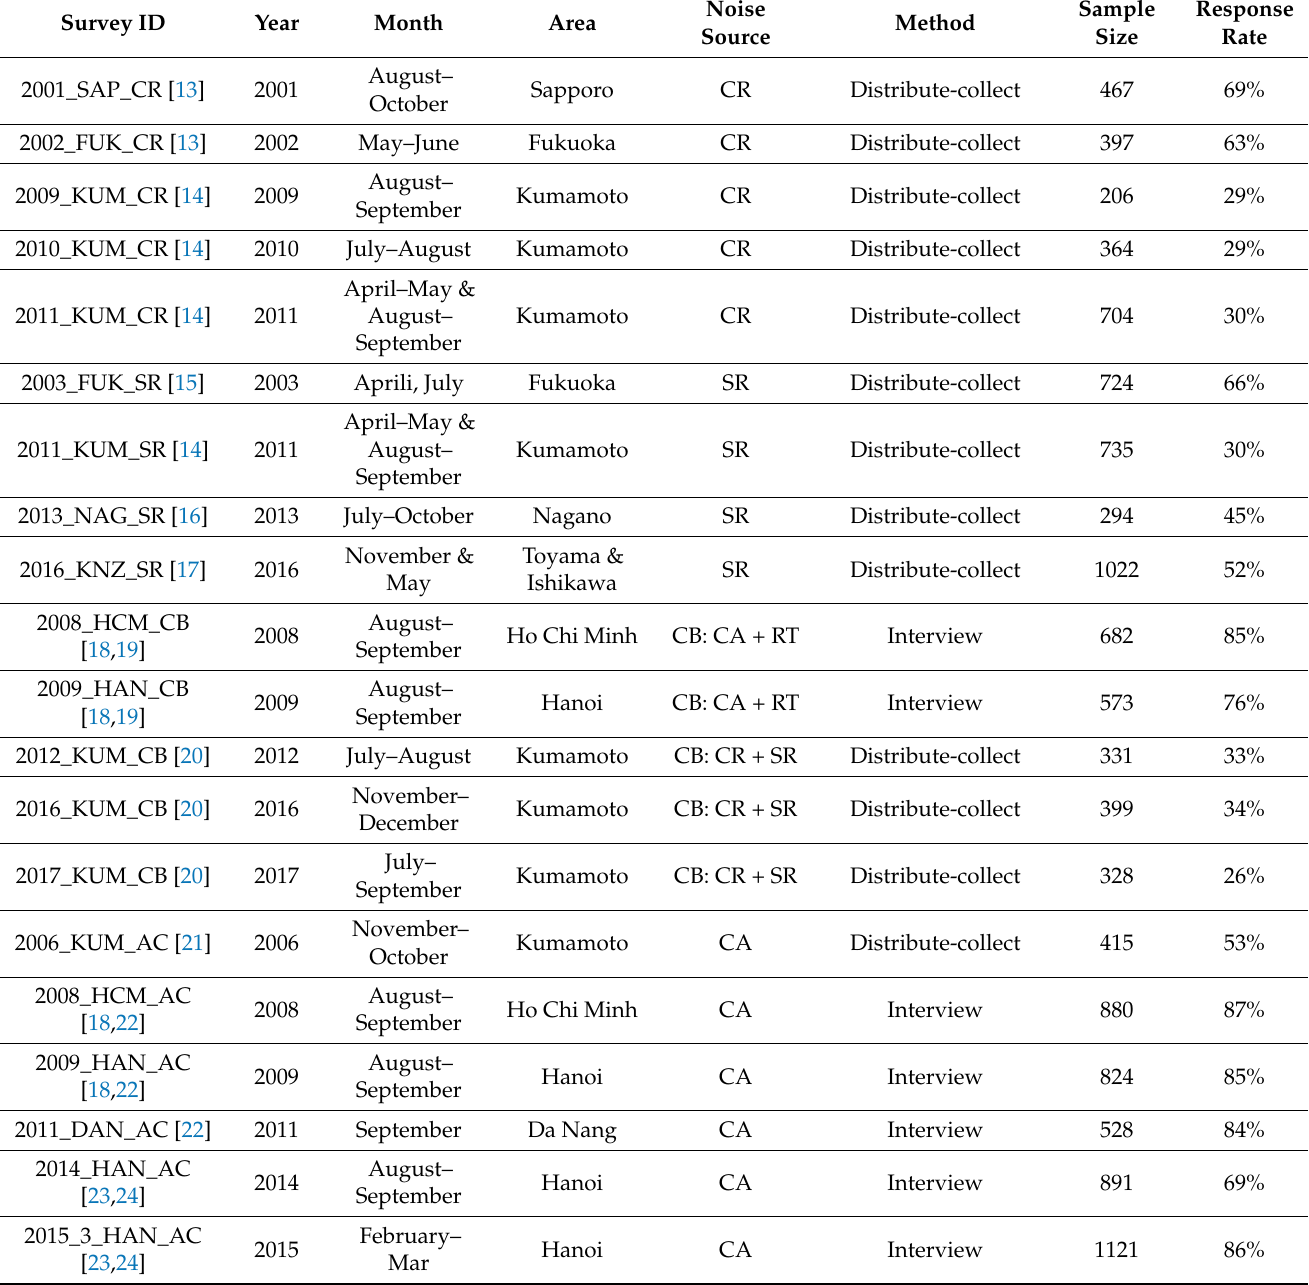
Table 1. List of datasets used in the present analysis. Abbreviations in the “Noise source” column indicate the following: CR, conventional railway; SR, shinkansen railway; CB, combined noise source; CA, civil aircraft; RT, road traffic. The numbers in the parentheses in the first column correspond to those of the references at the end of this paper. Survey